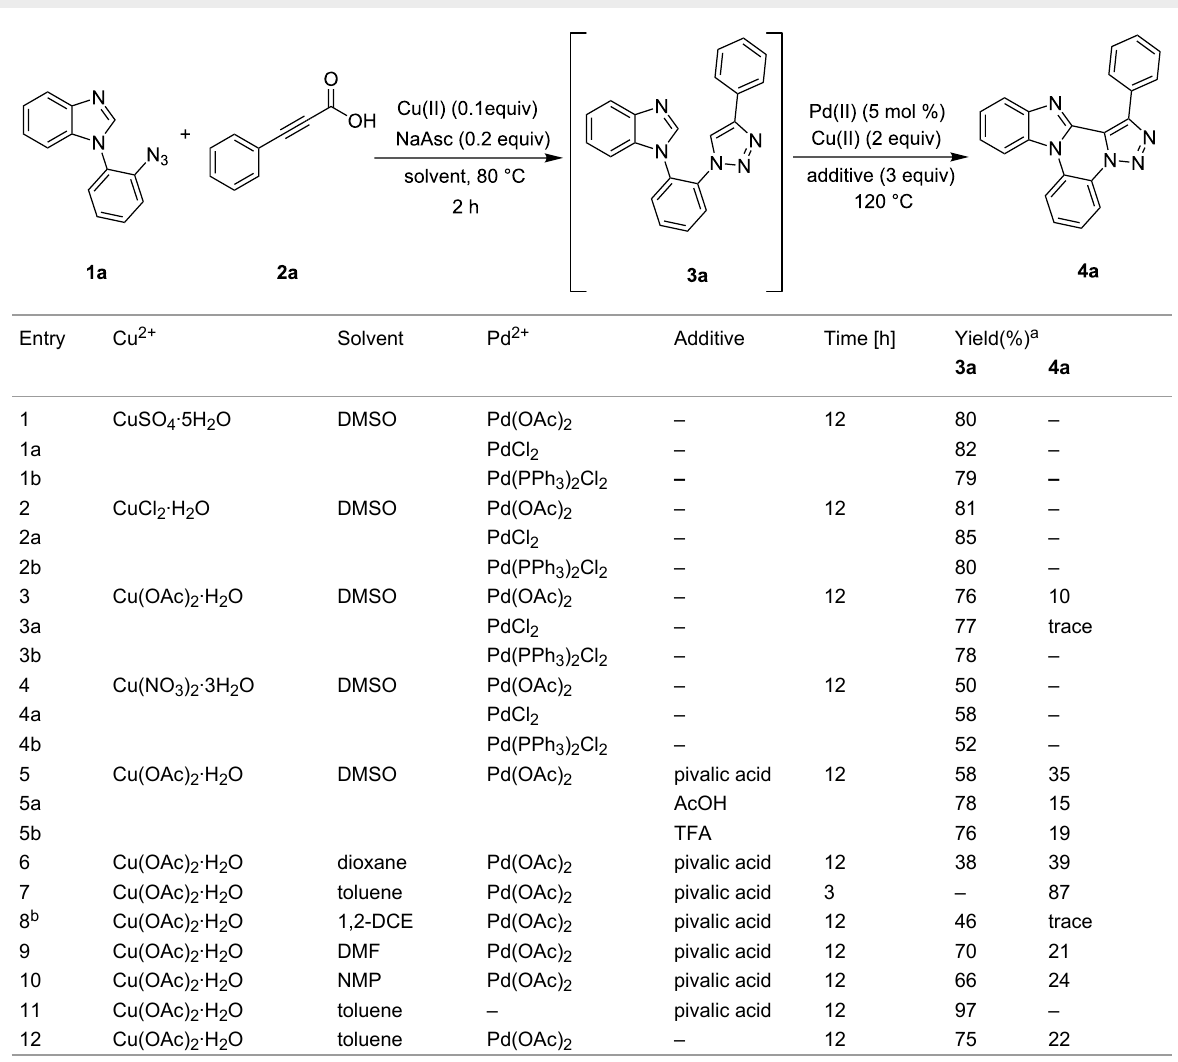
Table 1: Optimization of reaction conditions for the preparation of 4a